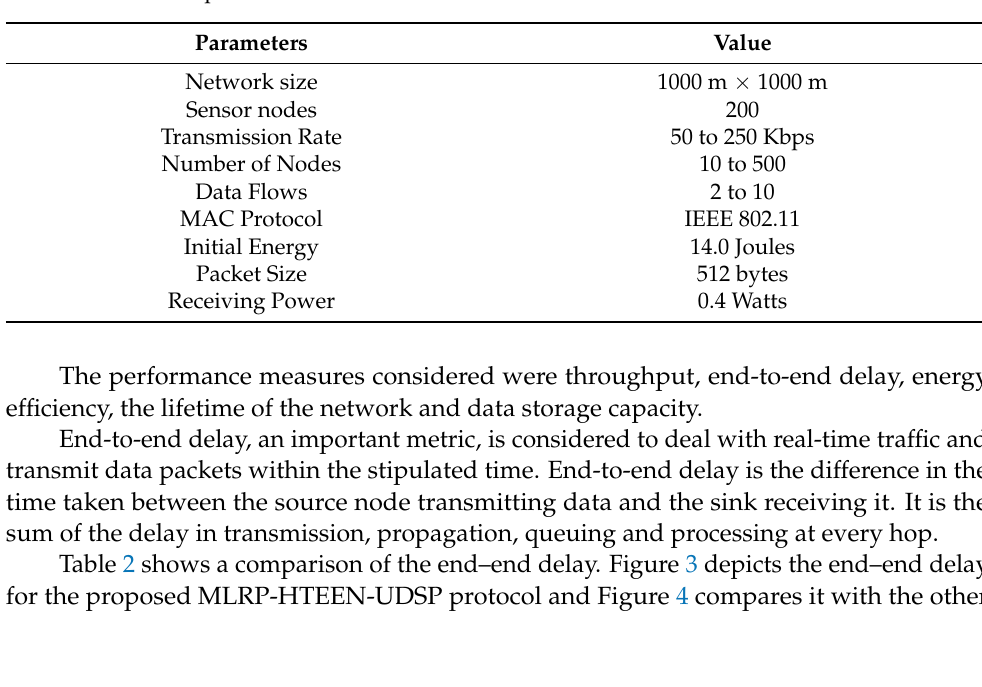
Table 1. Simulation